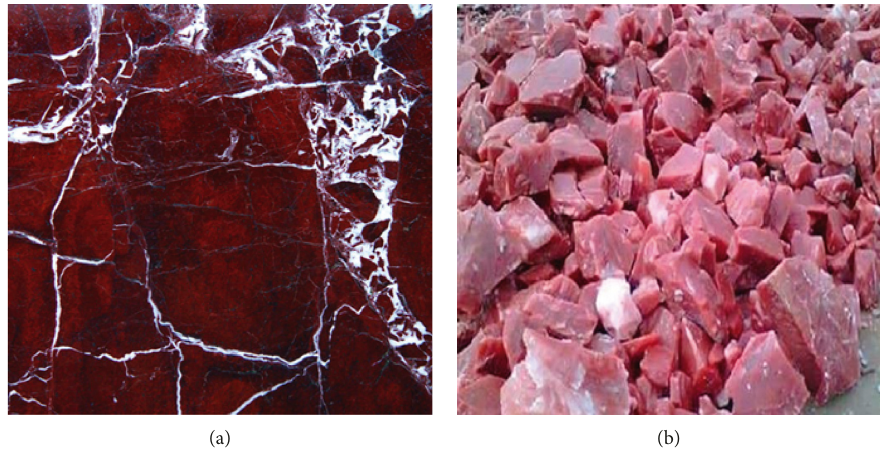
Figure 1: Elazig maroon marble block (a) and shredded maroon marble resembles cubed meat